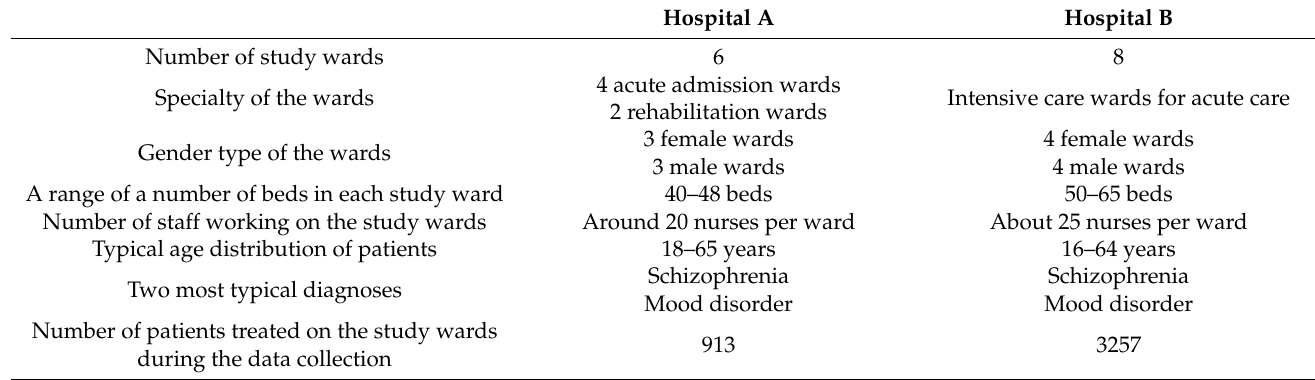
Table 1. Characteristics of the study wards (based on the hospital statistics on year